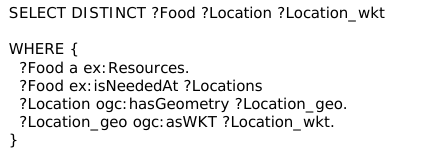
Figure 7. A GeoSPARQL for retrieving places requiring food